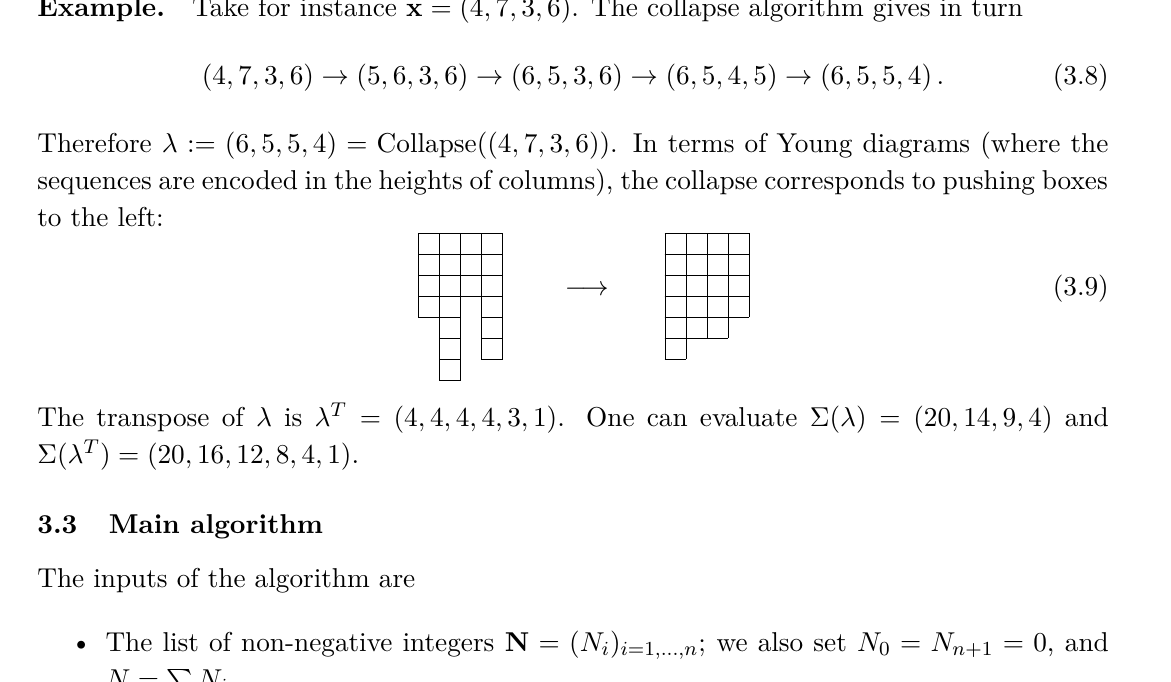
Figure 2 . Hasse diagram of lockings L 3 . Each locking is denoted using bars | . Using the brane web interpretation, this means for instance that 0 | 13 | 2 represents branes 1 and 3 being locked together, while the other two are free to move independently. The locking in the box is L ( s ) for example (3.2). The blue sub-diagram is the diagram of lockings compatible with L ( s ) (see definition on page 17).